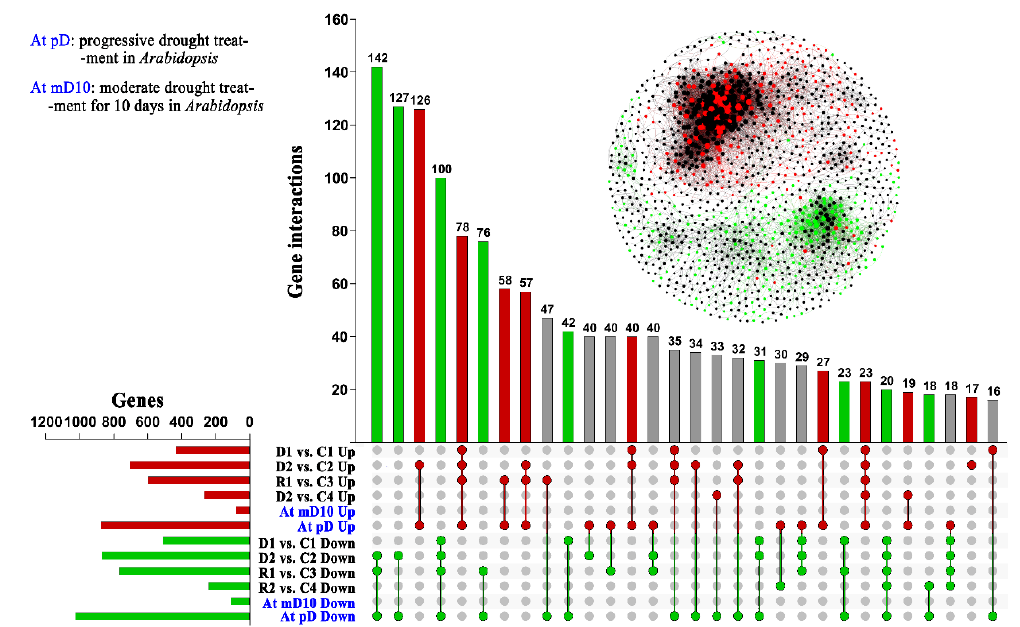
Figure 4. Gene clusters identification in drought-responsive genes and overlap with Arabidopsis: Red and green circles indicate Pt and at conserve drought-response genes, which in the Pt co-expression network, a red dot indicating these gene up-regulated in the D2, and green indicating down-regulated in D2. 70% (6163) genes have a homologous in Arabidopsis, in which 52% homologous (3178 genes corresponding to 2086 genes in Arabidopsis) were also drought-response genes in Arabidopsis.